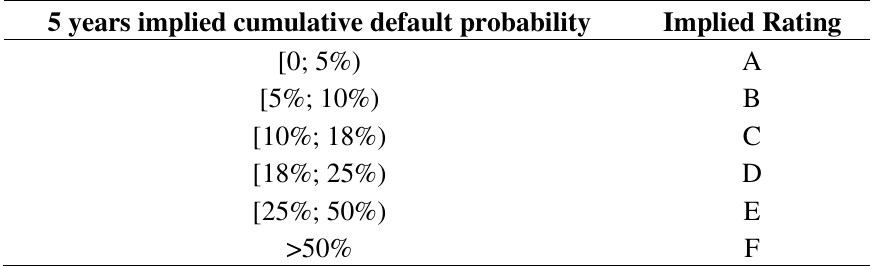
Table 1. Implied rating and default probability.